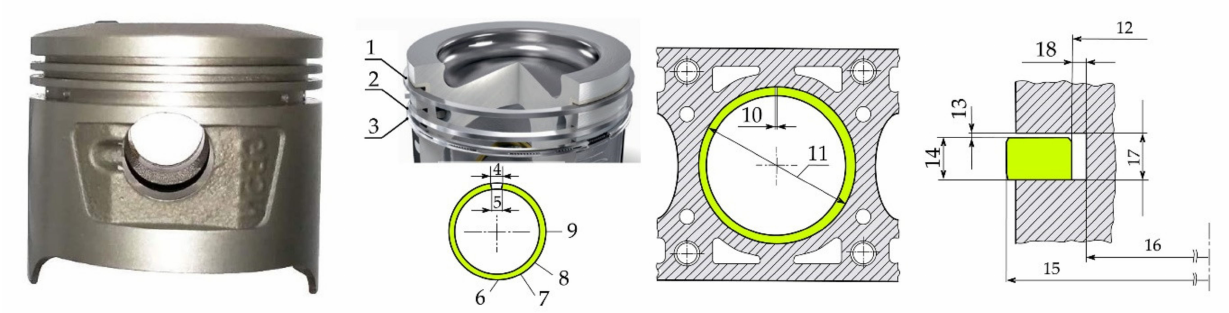
Figure 1. Common view of typical complete set of piston rings [37,38]: 1—Compression piston ring; 2—combined compression and oil removal piston ring; 3—oil removal piston ring; 4—clearance in the lock of the unstressed piston ring; 5—butt ends; 6—back of the ring (opposite the butt ends); 7—ring working surface; 8—side surface of the ring; 9—inner surface of the ring; 10—thermal gap (cold gap); 11—cylinder diameter; 12—radial wall thickness; 13—axial clearance; 14—piston ring height; 15—cylinder diameter; 16—groove inner diameter; 17—groove height; 18—radial clearance.